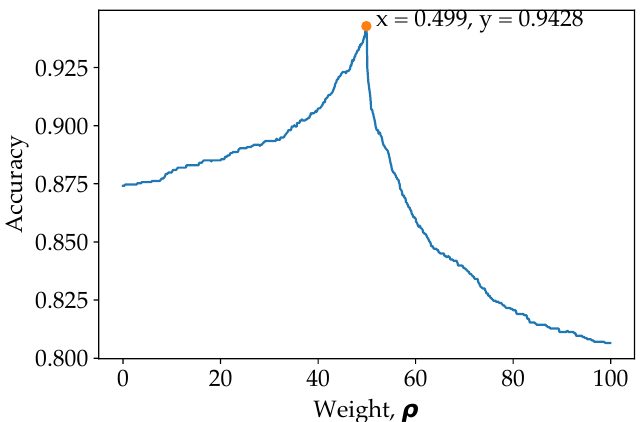
Figure 6. Grid search in determining the optimal weight, ρ